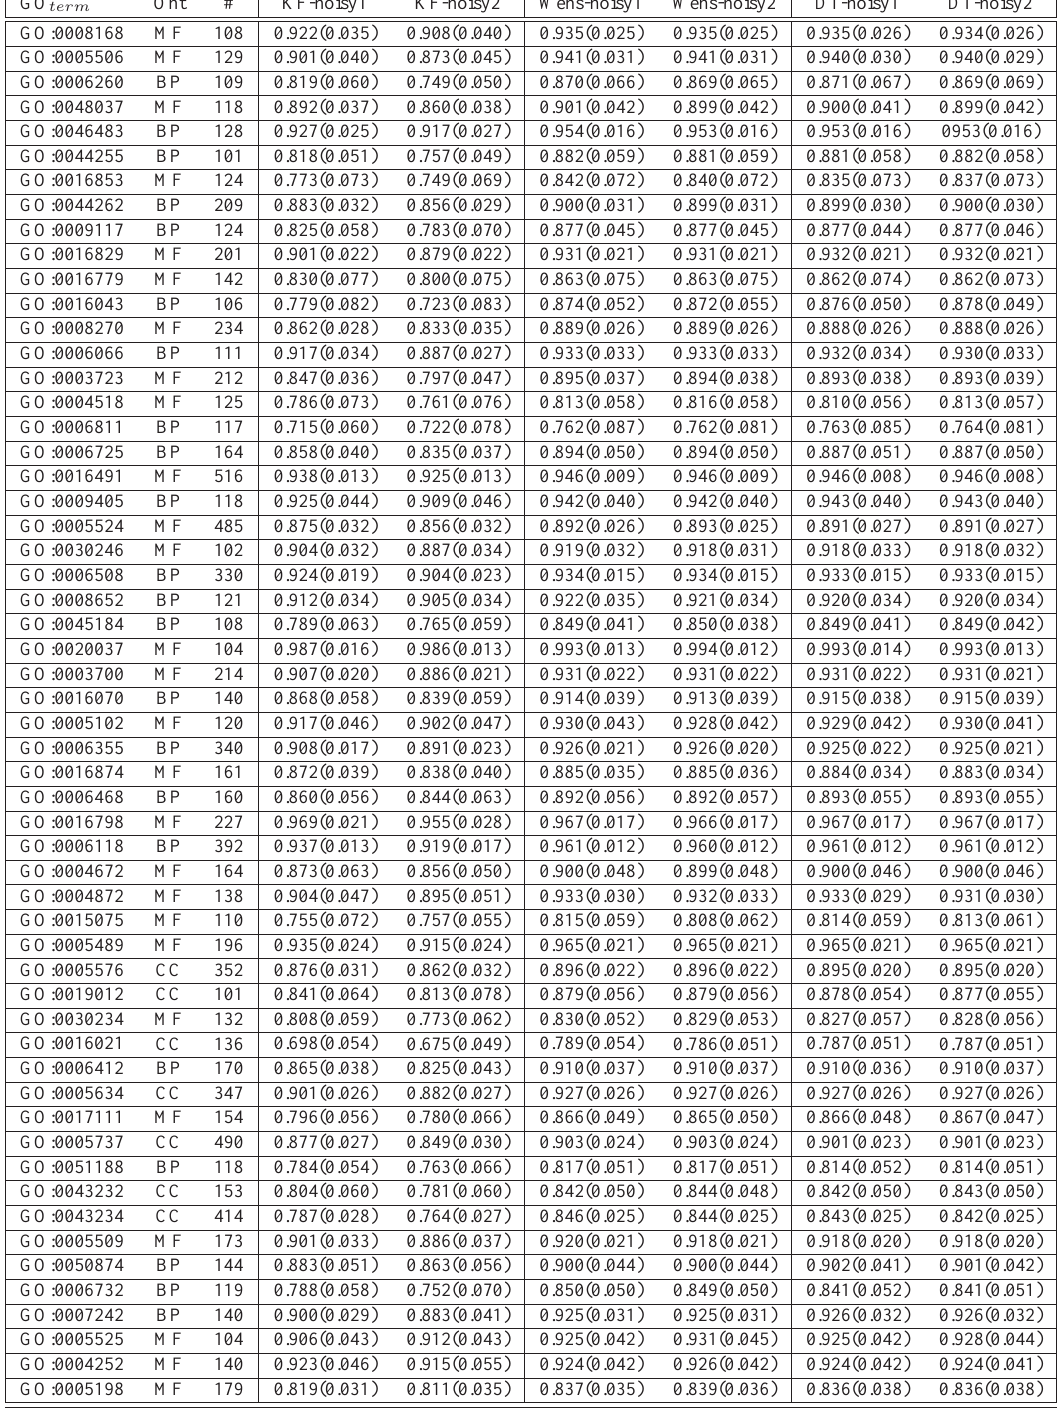
Table 3: Performances of data integration methods in presence of one and two synthetic noisy kernels (AUC averaged across the 15 folds). KF-noisy1 and KF-noisy2 stands for kernel fusion methods with 1 and 2 noisy kernels; Wens-noisy1 and Wens-noisy2 stands for weighted average ensembles with 1 and 2 noisy kernels; DT-noisy1 and DT-noisy2 for decision templates with 1 and 2 noisy